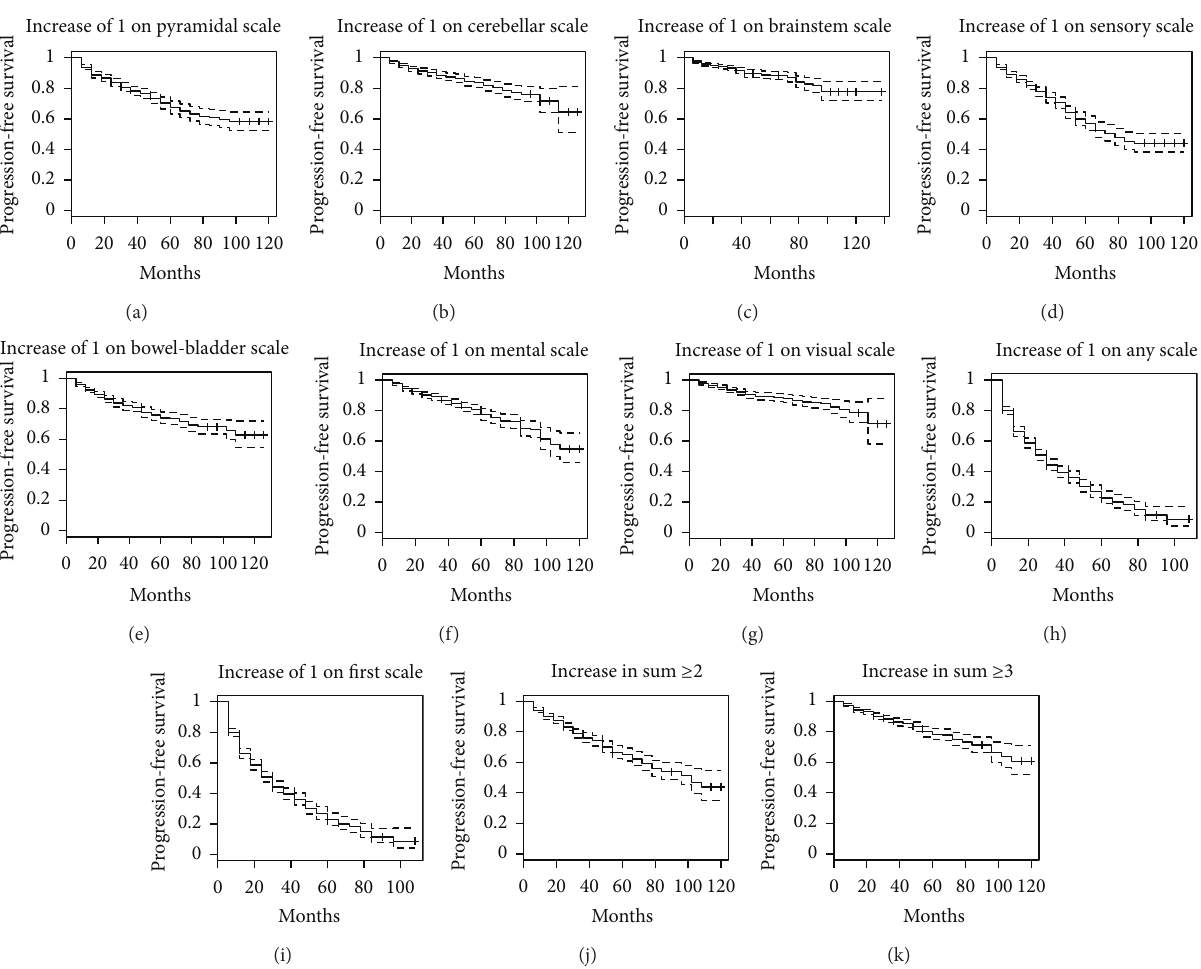
Figure 3: Time to sustained progression for functional system score definitions. Each graph represents a different definition of sustained progression: top row (from left to right)—increase on pyramidal subscale (D5), increase on cerebellar subscale (D6), increase on brainstem subscale (D7), increase on sensory subscale (D8); middle row (from left to right)—increase on bowel-bladder subscale (D9), increase on mental subscale (D10), increase on visual subscale (D11), increase on any subscale (D12); bottom row (from left to right)—increase in first subscale (D13), increase of 2 in the sum of the subscales (D14), increase of 3 in the sum of the subscales (D15).